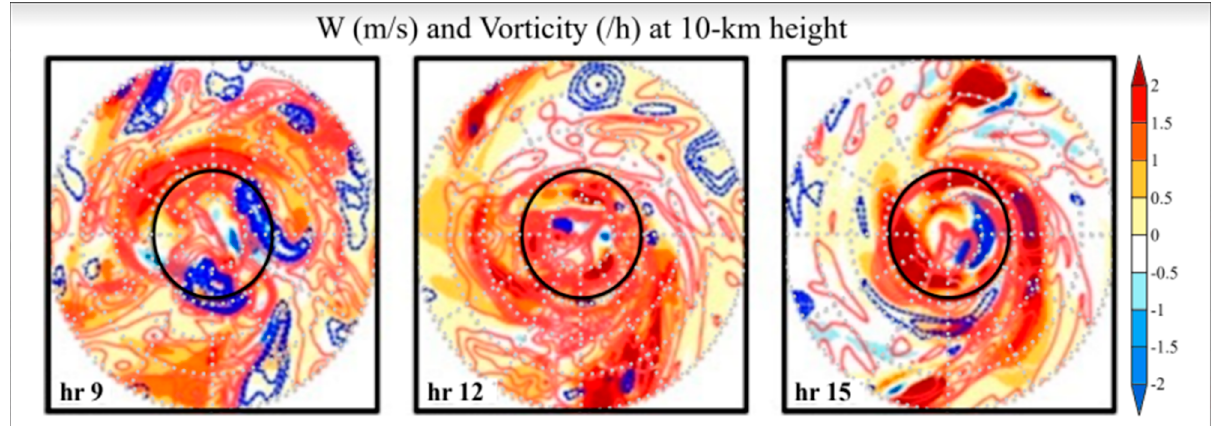
Figure 10. Azimuthal structure of vertical velocity (units of m s − 1 , shaded) and relative vorticity (units of h − 1 , contours) at 10 km height during the RI of Hurricane Irma. In all panels, red contours/shades denote positive values, and blue contours/shades denote negative values. The contour interval is 1.0 h − 1 . The black ring indicates the approximate radius of maximum surface wind. Each box is 200 km × 200 km, with dashed gray range rings every 50 km.